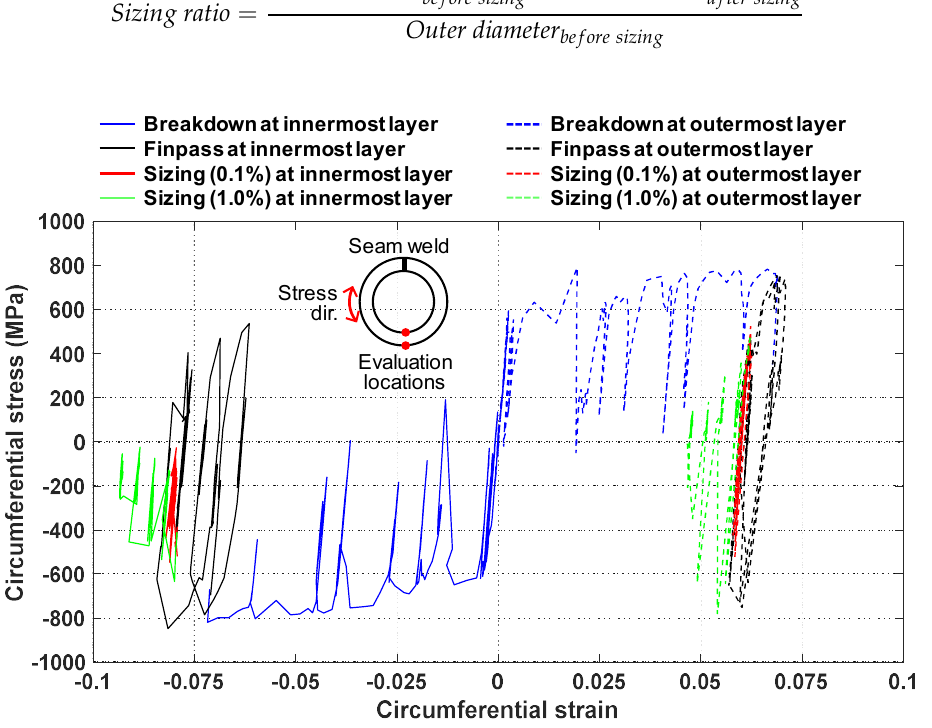
Figure 7. Stress–strain curve at the outer and inner layers during manufacture.